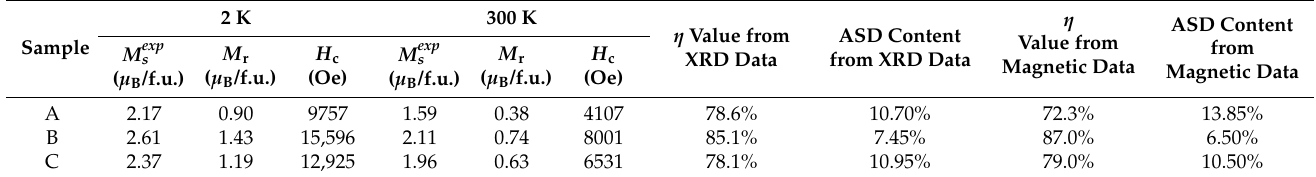
Figure 6. M-H hysteresis loops of samples A–C measured at 2 K and 300 K, respectively. ( a ) Sample A, ( b ) sample B, ( c ) sample C. Table 2. Magnetic properties of samples A–C and their Fe/Re ordering degrees ( η ), and the ASD contents deduced from the XRD data and magnetic data,